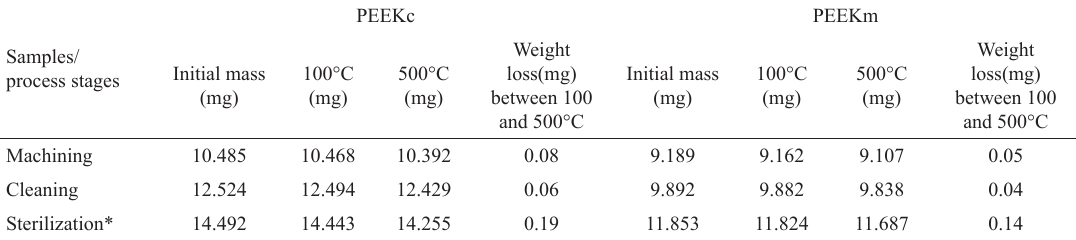
Samples/ process stages